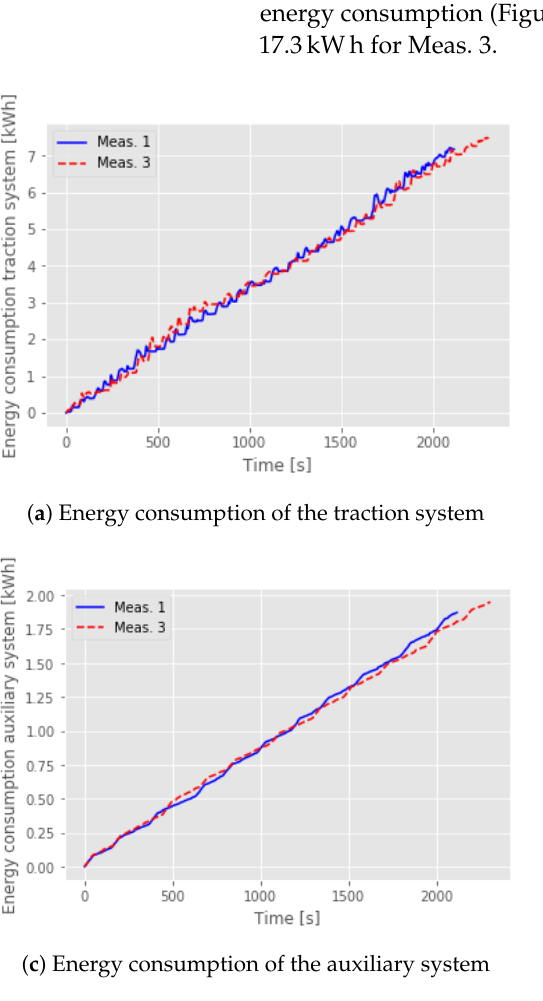
Figure 6. Comparison of the energy consumption of the e-bus with heating off (Meas. 1, blue, solid line) and on (Meas. 3 red, dashed line). The energy consumption of ( a ) the traction system, ( b ) the heating, ventilation, and air conditioning (HVAC) system, and ( c ) the auxiliary system is shown, as well as ( d ) the total used